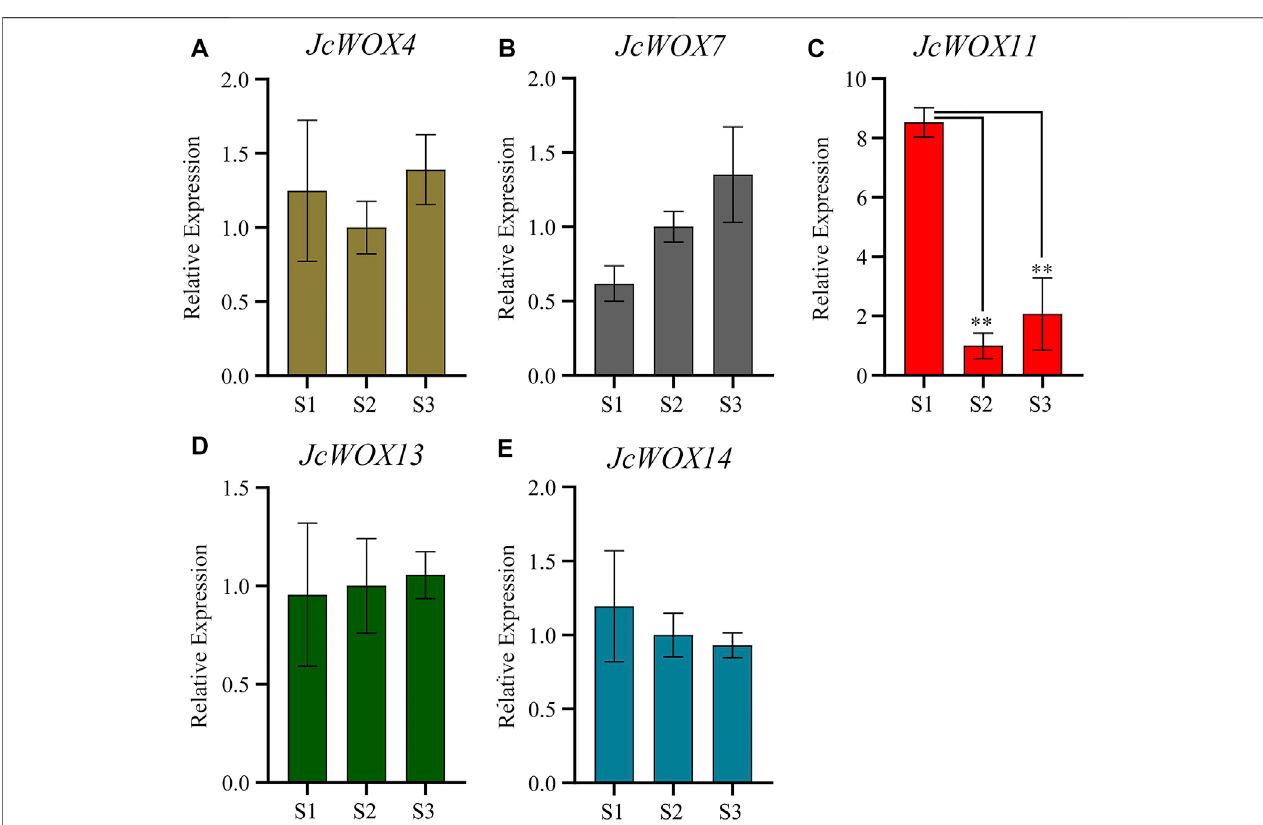
FIGURE7| Expressionof fi ve JcWOX genesincallusinqRT-PCRexperiments(Student ’ s t -test:** p < 0.01). (A) JcWOX4 ; (B) JcWOX7 ; (C) JcWOX11 ; (D) JcWOX 13 ; (E) JcWOX14 .